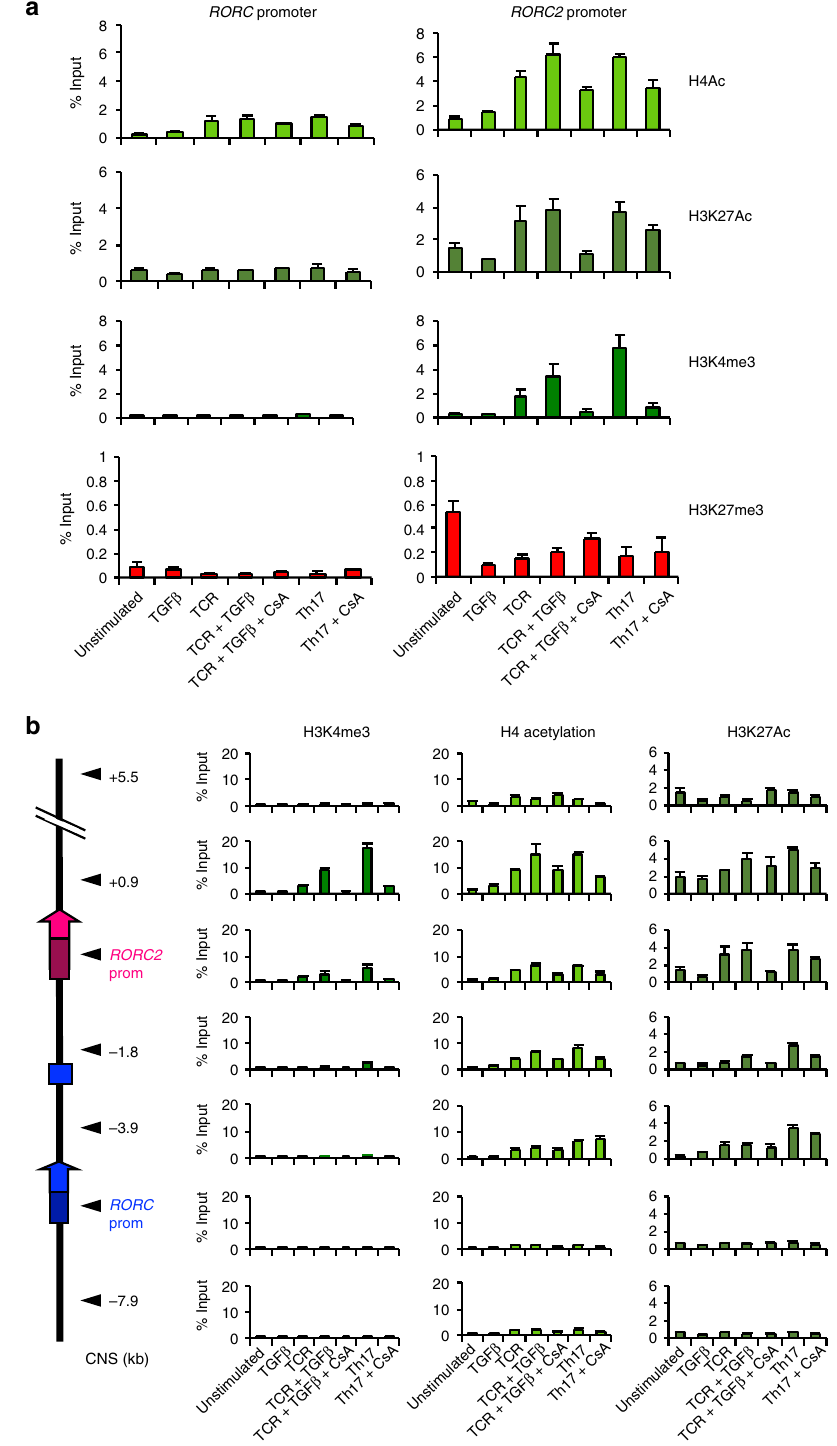
Fig. 6 NFAT activation promotes epigenetic remodeling at the RORC2 locus. a Epigenetic modi fi cations at the RORC 2 promoter in cord blood CD4 + T lymphocytes are calcineurin-sensitive. Cord blood CD4 + T lymphocytes were stimulated 20 h as indicated. ChIP was performed with antibodies against H4Ac, H3K27Ac, H3K4me3 and K3K27me3. b ChIP was performed with antibodies recognizing the following modi fi cations: H3K4me3, H4Ac and K3K27Ac. The diagram on the left shows the regions analyzed. Enrichment is represented as percent of input DNA. CsA: Cyclosporine A. Data represent average and standard deviation of three replicates. Source data are provided as a Source Data fi